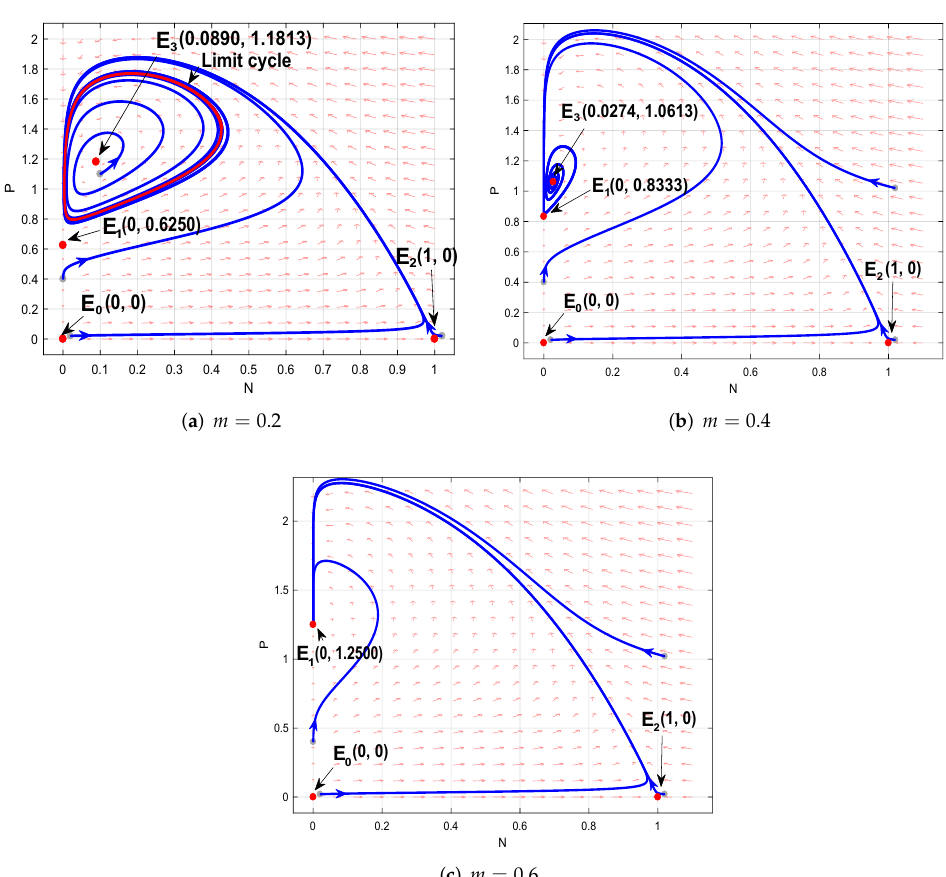
Figure 8. Phase Portraits of the system (3) with parameter values as in Table 4 and ( a ) m = 0.2, ( b ) m = 0.5, and ( c ) m =